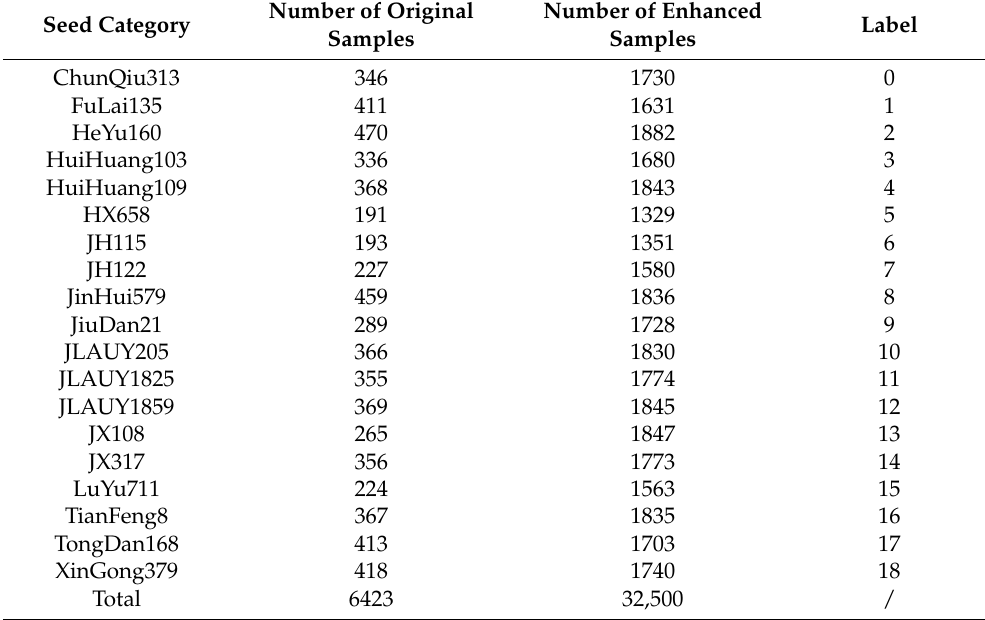
Table 1. Profile of samples.